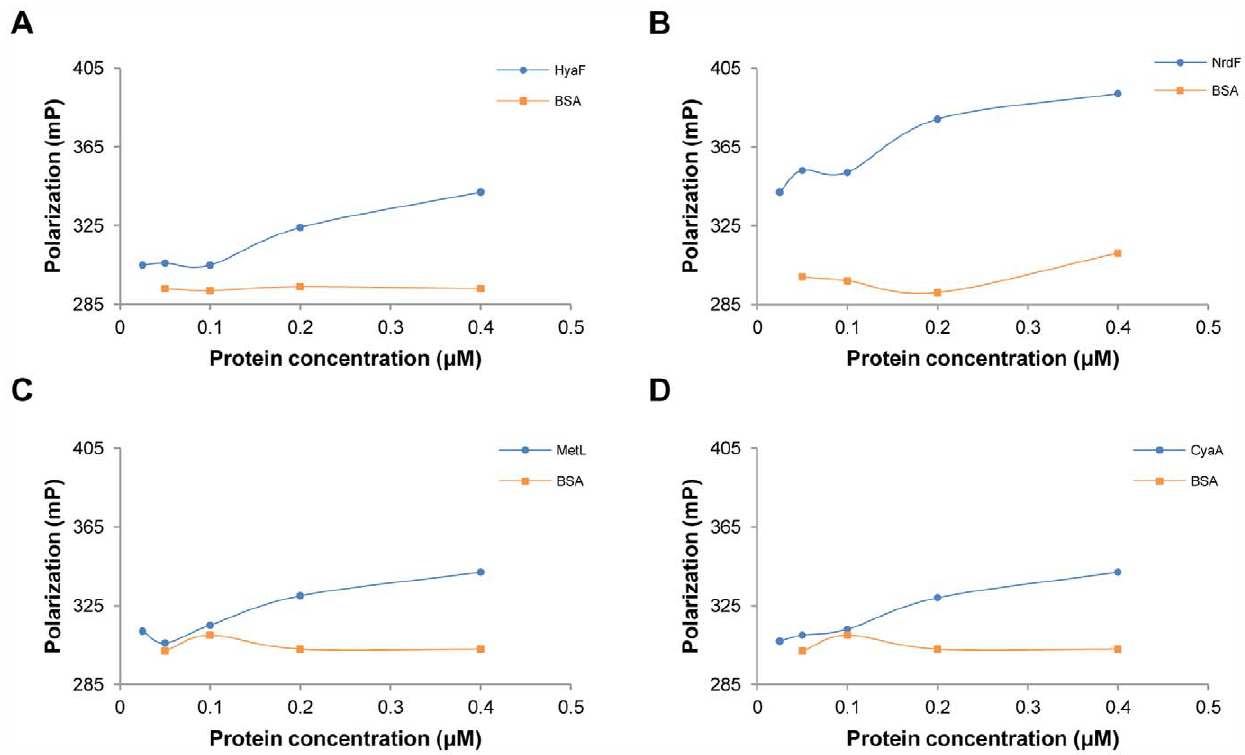
Figure 5. Validation of the interactions between LfcinB and proteins using fluorescence polarization assays. FP assays provide a homogeneous-based environment for a binding test, eliminating immobilization and separation procedures. We used FP assays to conduct screening for protein-peptide interactions. The rotation of fluorescently labeled LfcinB (a small molecule) is faster and hence causes the emitted light to be depolarized. When LfcinB binds to the target proteins, the molecular weight becomes larger and makes the rotation slow. Thus, the degree of polarization becomes higher. In FP assays, the polarization values of the tested proteins were compared with BSA (negative control). The blue circle is a sample and the orange square is BSA. Sixteen out of the 153 proteins have apparent differences from BSA. A. HyaF, B. NrdF, C. MetL and D. CyaA are representative FP results.